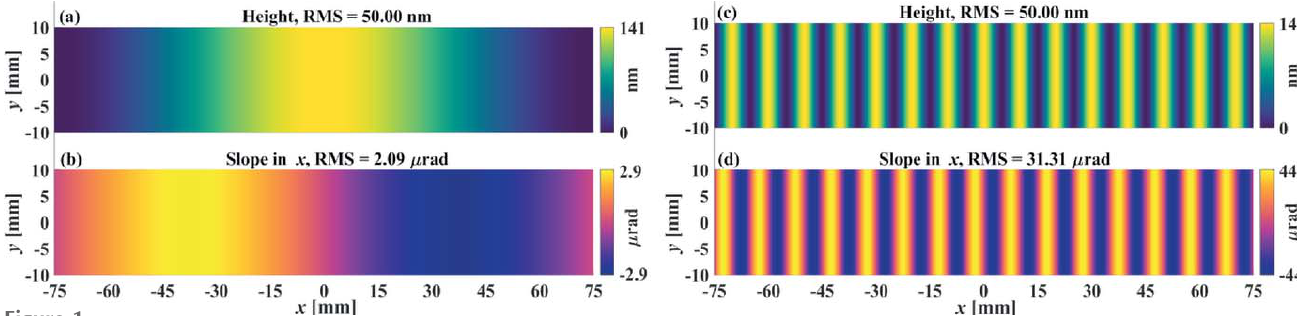
Figure 1 The height errors in ( a ) and ( c ) are generated using equation (1) with ( f x , f y ) = (150, 0) mm (cid:2) 1 and ( f x , f y ) = (10, 0) mm (cid:2) 1 , respectively. Although they have the same height error of 50 nm RMS, the corresponding slope errors shown in ( b ) and ( d ) are very different from each